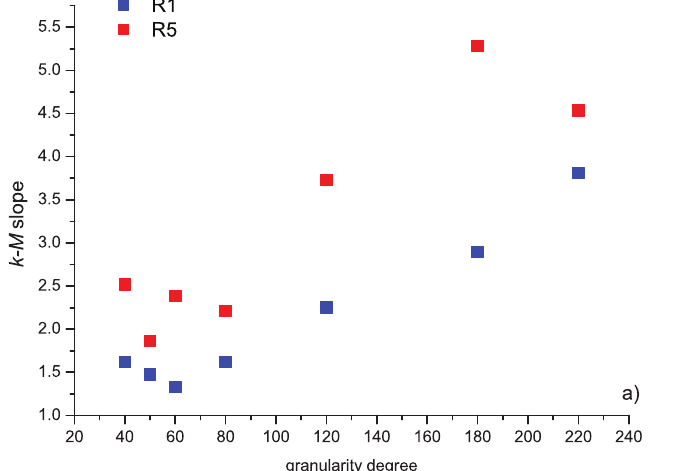
Figure 7. Relationship between the k-M slope (of the LSM fitting line), the run and the granularity degree of the aluminum track (the sandpaper coating the inferior surface of the moving block has roughness degree 36 in all the experiments). The first run is indicated by R1, while the last fifth one by R5.